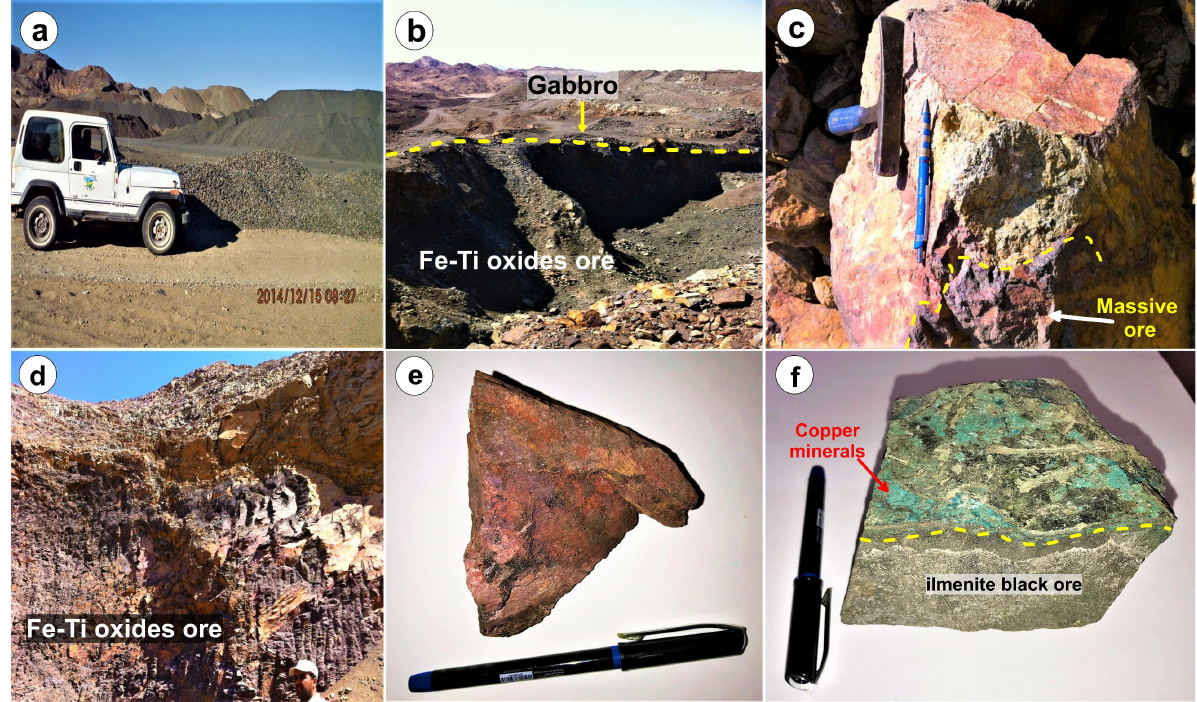
Figure 4. Field relationships between the Fe-Ti oxides bodies and their host rocks. ( a ) Abu Ghalaga mine. ( b ) Black (fresh) ore and red (oxidized) ore hosted in the gabbroic rocks. ( c ) Massive ore. ( d ) and ( e ) Black (fresh) ore and red (oxidized) ore. ( f ) Green copper mineral staining along the boundaries of ilmenite ore.